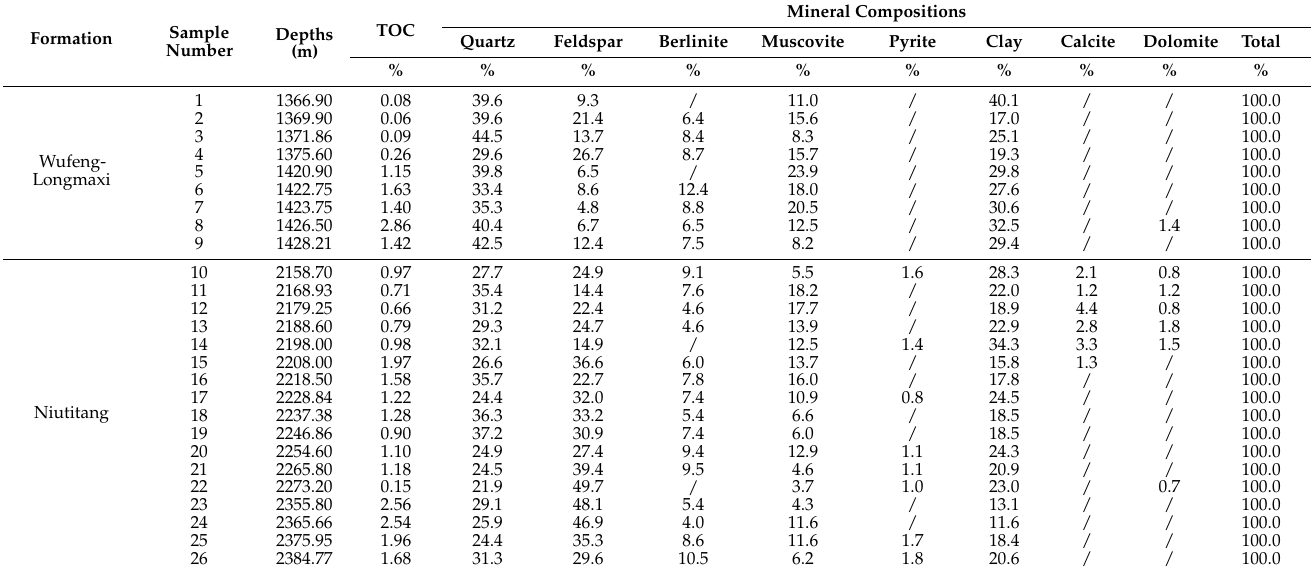
Table 1. TOC contents and mineral compositions of Wufeng-Longmaxi and Niutitang samples.